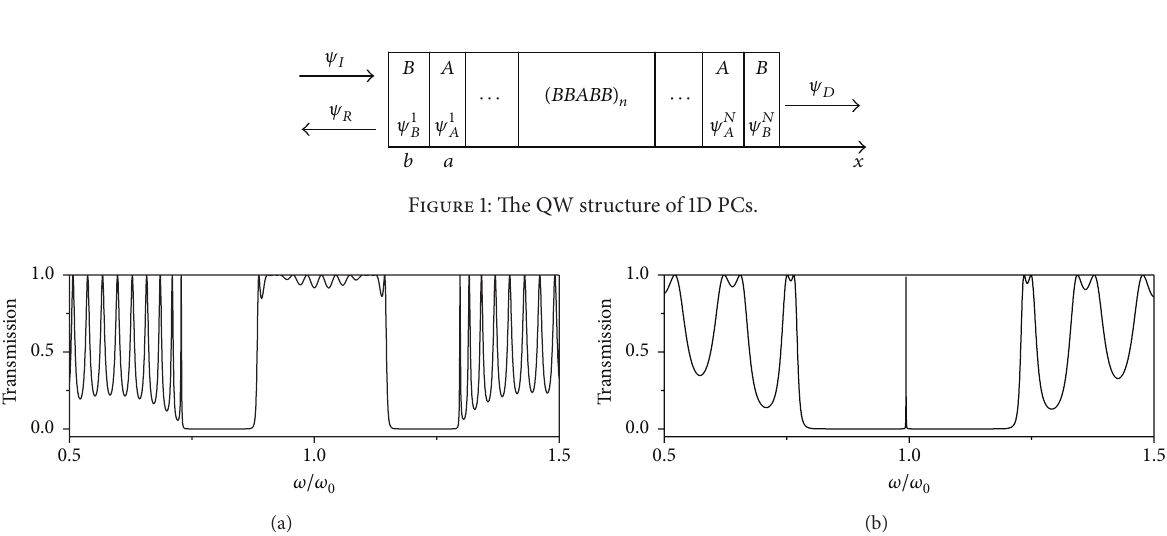
Figure 2: The quantum transmissivity of 1D PCs with 𝑛 𝑏 = 2 . 45. (a) The structure is (𝐵𝐵𝐴𝐵𝐵) 12 ; (b) the structure is (𝐵𝐴) 6 (𝐴𝐵) 6